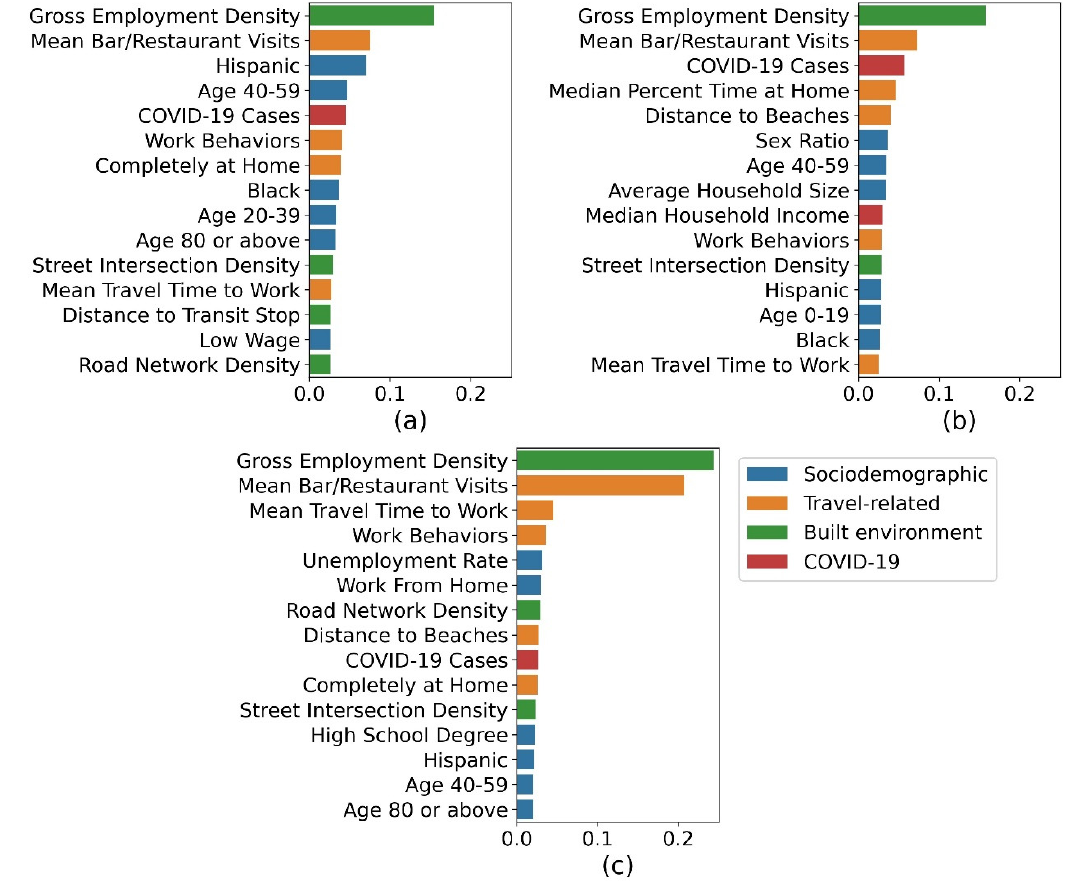
Figure 6. The relative importance of the top 15 variables for the inflow trips per person (06/16–07/31/2020) using random forest models for ( a ) Miami-Dade County, ( b ) Broward County, and ( c ) Palm Beach County.